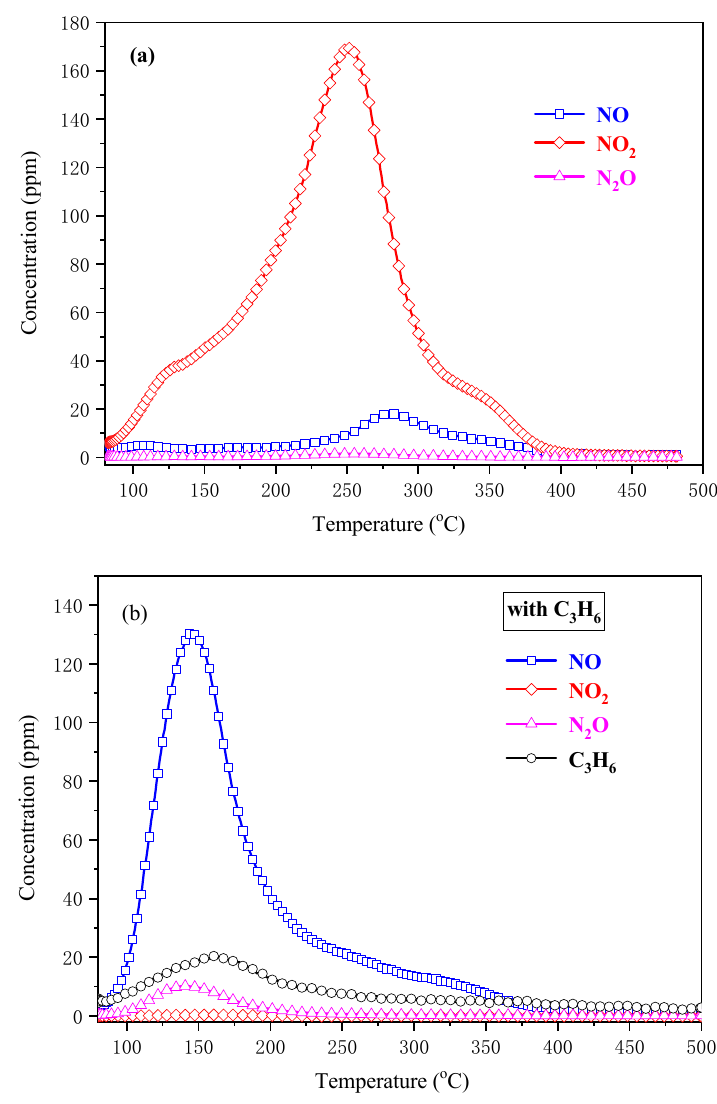
Figure 7. NO x -TPD profiles over the Cu-SAPO-34 catalyst without C 3 H 6 ( a ) and with C 3 H 6 ( b ).